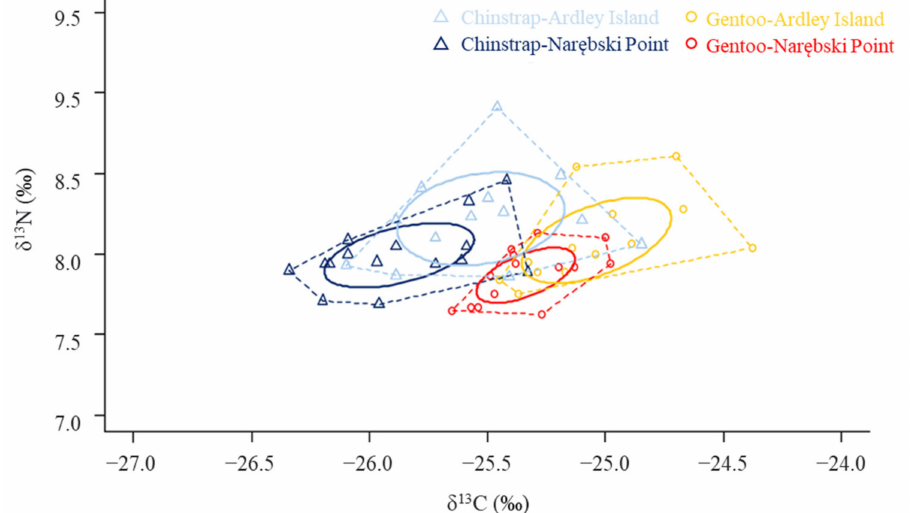
Figure 3. Stable isotope values of δ 13 C and δ 15 N in Chinstrap and Gentoo penguins at Ardley Island and Nar˛ebski Point. Standard ellipses indicate 40% prediction. Individual numbers were 13 at AI and 16 at NP of Chinstrap and 13 and 13 of Gentoo penguins,